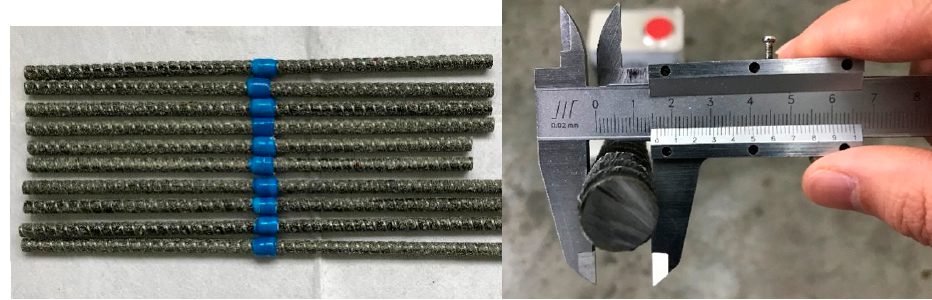
Figure 8. BFRP bars.